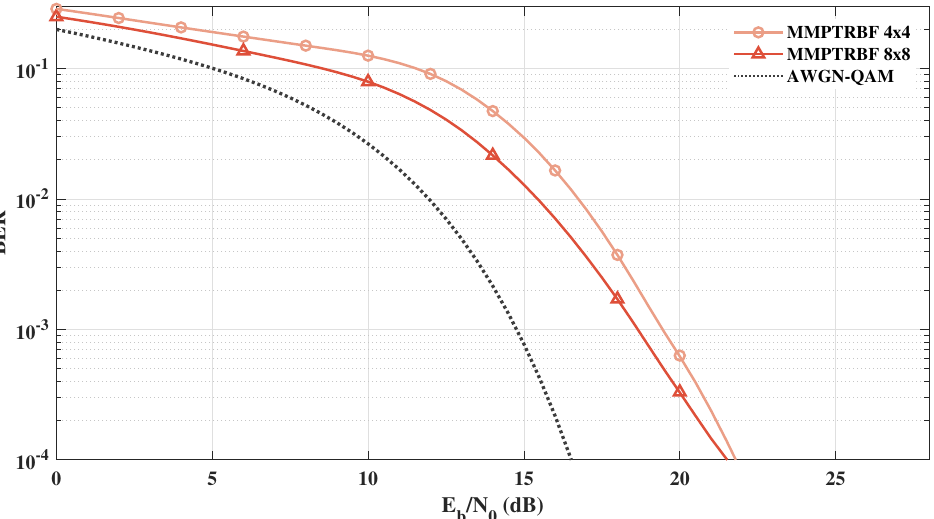
Figure 24. MMPTRBF with M T = M R = 4 and 8 antennas operating at the same bitrate with 64-QAM modulation.